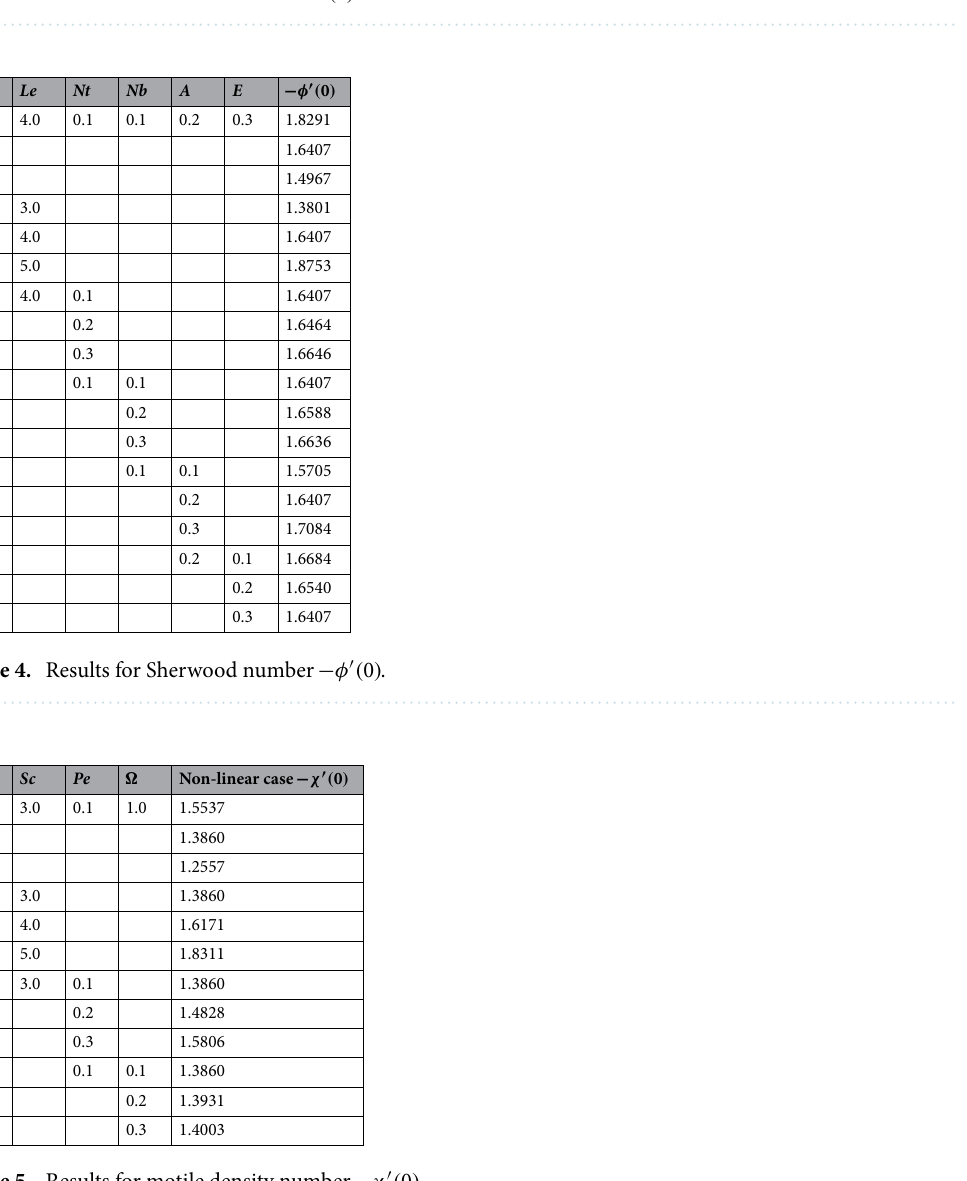
Table 3. Results for Nusselt number